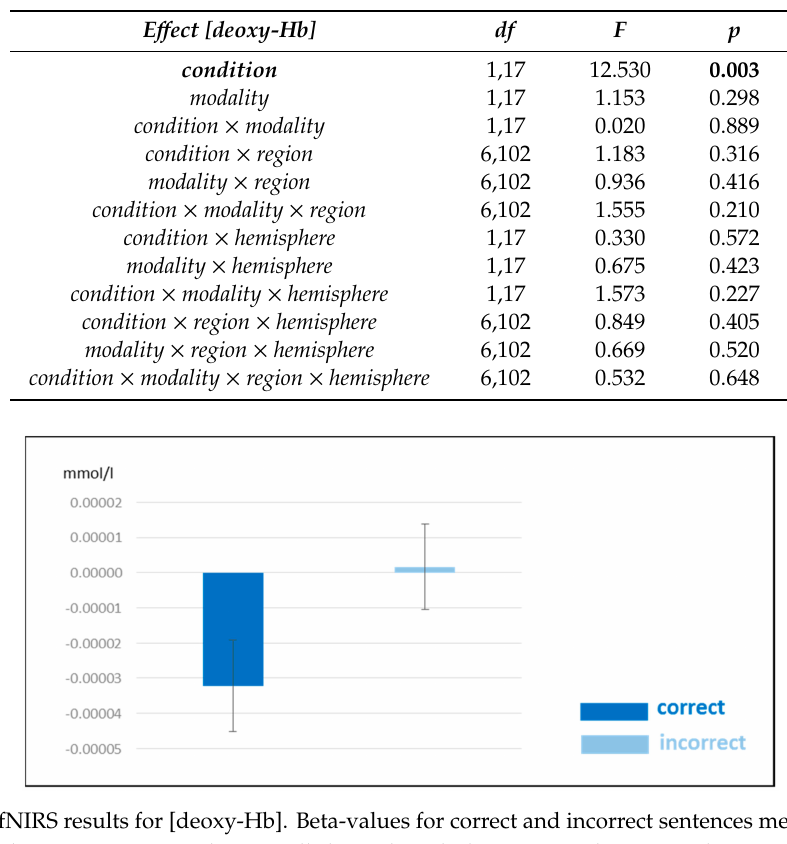
Table 4. Statistical results of the ANOVA condition × modality × region × hemisphere for [deoxy-Hb] of fNIRS data. Significant e ff ects ( p < 0.50) are marked in bold.